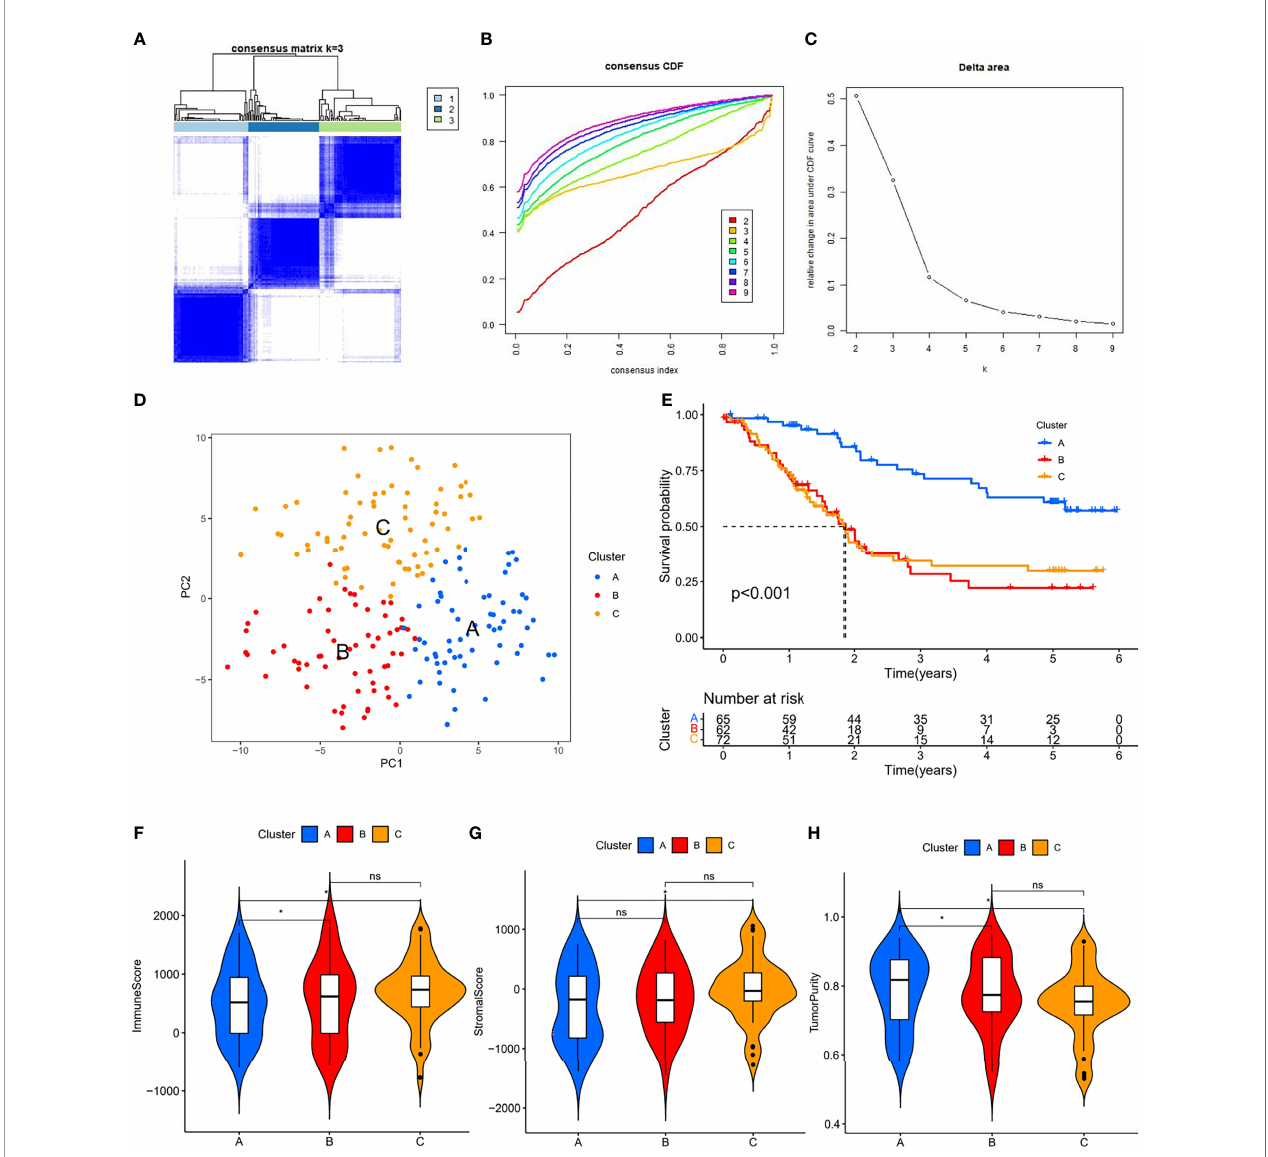
FIGURE 2 | ER-lncRNA subtypes. (A) Consensus clustering matrix when k = 3. (B) Consensus clustering CDF with k valued 2 to 9. (C) Relative change in area under the CDF curve for k = 2 through 9. (D) PCA analysis showed that ESCC could be well differentiated into three subtypes based on the expression of ER- lncRNA. (E) Kaplan-Meier curves of OS for three subtypes in ESCC. Differences in immune score (F) , stromal score (G) and tumor purity (H) between different subtypes. ns, not signi fi cant, * P <